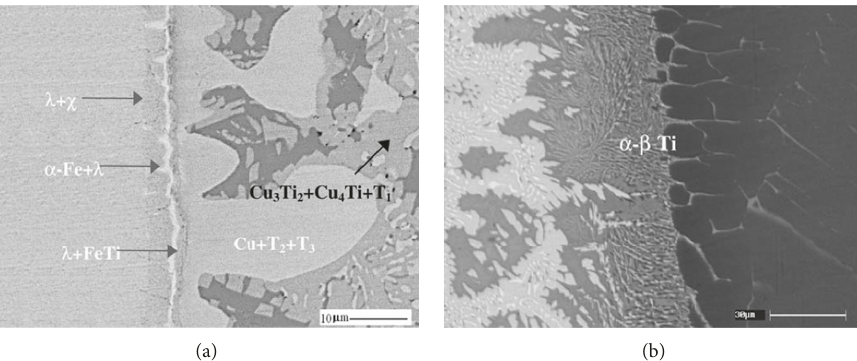
Figure 4: BSE image of the specimen processed for 60min at (a) 900 ° C, SS-Cu interface and (b) 900 ° C, CuTi interface (reproduced from [35] with